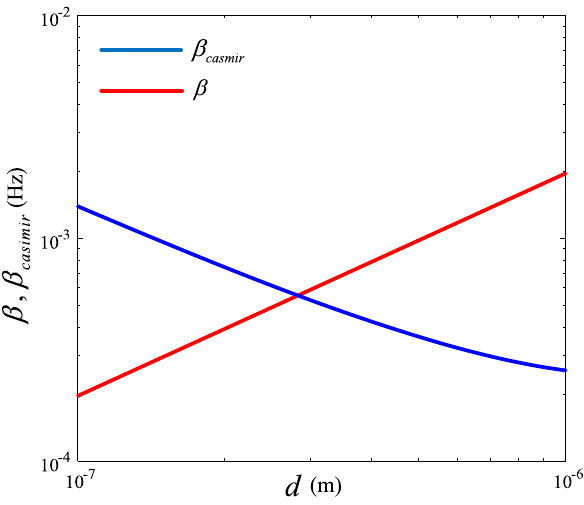
Fig. 3 The coupling strength of extra dimensions and Casimir as a function of thickness of the microdisks. Under the condition of d = 1 µ m, the Casimir coupling is about 8 times less than the gravitational coupling. The parameters are taken from Table 1